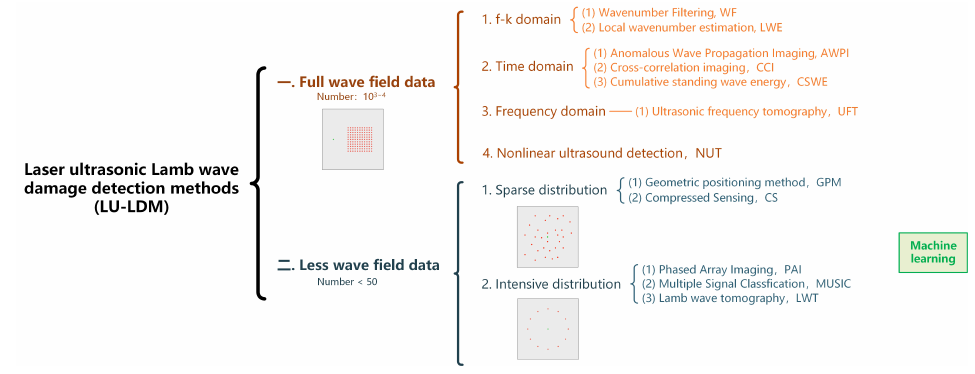
Figure 5. The overall framework of